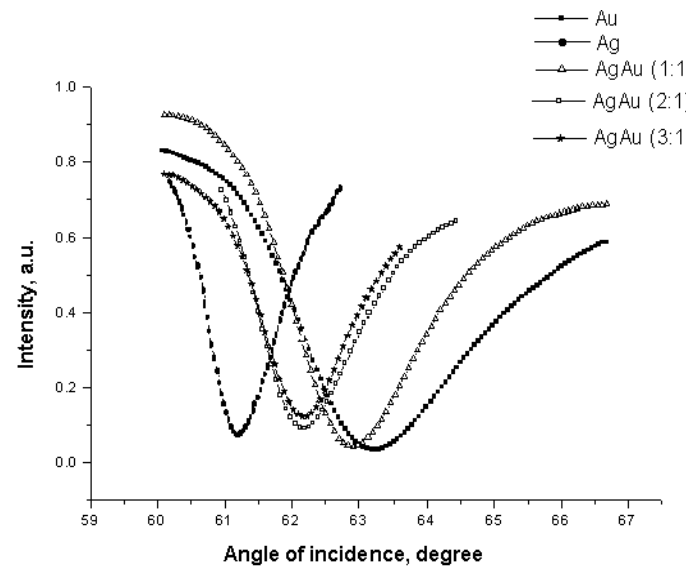
Figure 3. Influence of refractive index of ambient aqueous solution on resonance angle, measured with gold and gold/silver active phases. Refraction index was modified by addition of ethanol. The bimetallic layer consisted of equally thick silver and gold layers, the gold layer was in contact with the solution.